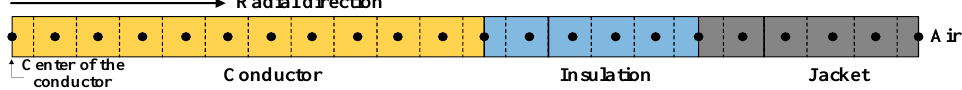
Figure 4. Cable discretization along the radial axis. The heat transfer problem is solved along the radial axis because the heat is con- ducted through this axis. This approach assumes that the central point of any node has the mean temperature of the discrete element where it is placed. This assumption is accu- rate since a small spatial step Δ x is chosen. The finite difference method (FDM) determines the nodal temperature from the temperatures of the two contiguous left-hand and right- hand side nodes. A tri-diagonal matrix describing the nodal temperature arises, so the temperatures can be determined by applying the tri-diagonal matrix algorithm (TDMA) [34], which has the form [12],